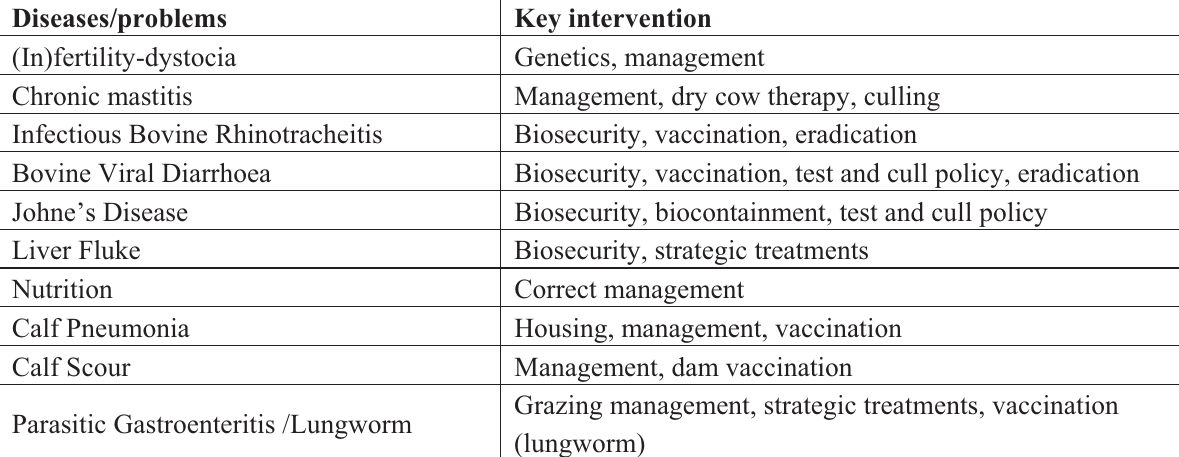
Table 4. Some proposed key interventions for the ten most important diseases in beef cattle in Great Britain (not ranked in order of importance; CHAWG report